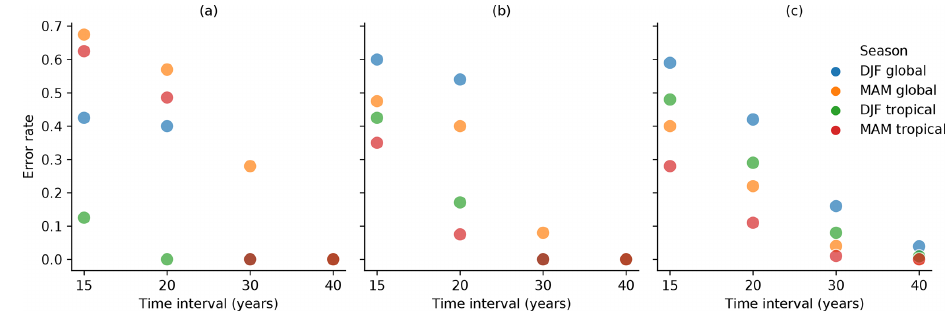
Figure A10. Error rate of the sliding window in 15-, 20-, 30-, and 40-year intervals. For each sliding window, the error rate is calculated by the number of invalid predictions (with significance P > 0 . 05 in ρ SLP of CO 2 time series) divided by the number of total predictions. With SLP in DJF global, MAM global, DJF tropical, and MAM tropical as predictors, the error rates of ρ SLP of (a) AGR R , (b) SL DGVMs , and (c) CESM are plotted.